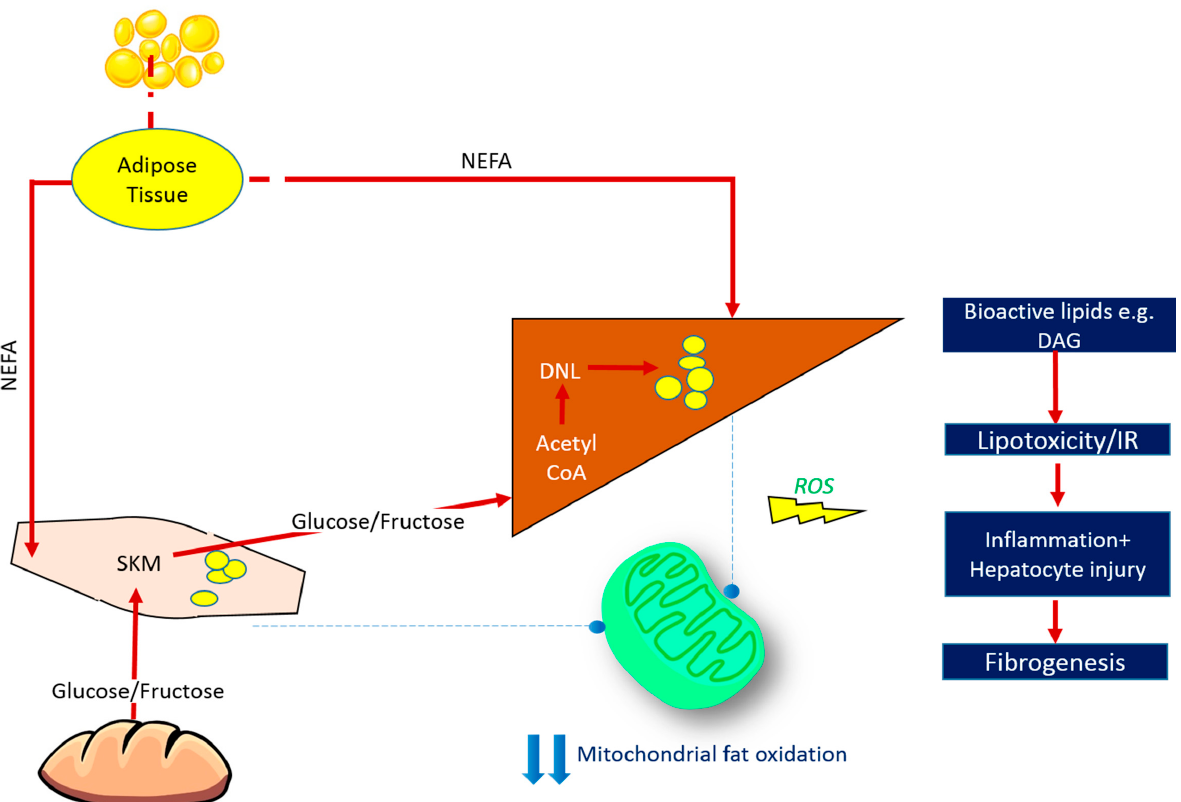
Figure 1. Fate of Ingested Macronutrients in States of Chronic Energy Surplus . Insulin resistance arises when nutrient storage pathways, which evolved to maximise efficient energy utilisation, are exposed to chronic energy surplus. Ectopic lipid accumulation in liver and skeletal muscle disrupts insulin signalling in these tissues, leading to reduced muscle glucose uptake and impaired hepatic glycogen synthesis. Muscle insulin resistance diverts ingested glucose to the liver, resulting in increased hepatic de novo lipogenesis and hyperlipidaemia. Increased liver fat stores are thus attributable to both increased free fatty acid (FFA) flux from insulin-resistant adipose tissue, and also diversion of dietary carbohydrate away from muscle glycogen synthesis and towards lipogenic pathways in the liver. The most biologically active form of liver fat is diacylglycerol, which is probably the moiety most directly responsible for impaired insulin signalling, with triglyceride being relatively metabolically inert. Reduced mitochondrial oxidative capacity in these tissues diminishes the ability of stored lipids to undergo oxidation, further exacerbating lipotoxicity and contributing toward oxidative stress. This culminates in necroinflammation and the onset of hepatic fibrogenesis. ROS = reactive oxygen species, SKM = skeletal muscle, NEFA = non-esterified fatty acids, DNL = de novo lipogenesis, DAG = diacylglycerol, IR = insulin